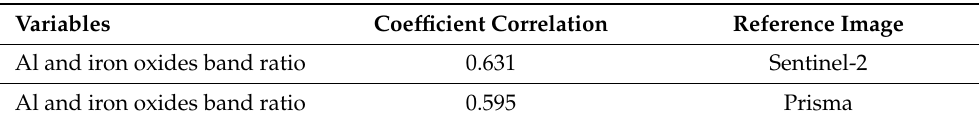
Table 2. Selected variables and their correlation coefficients for concentration mapping.